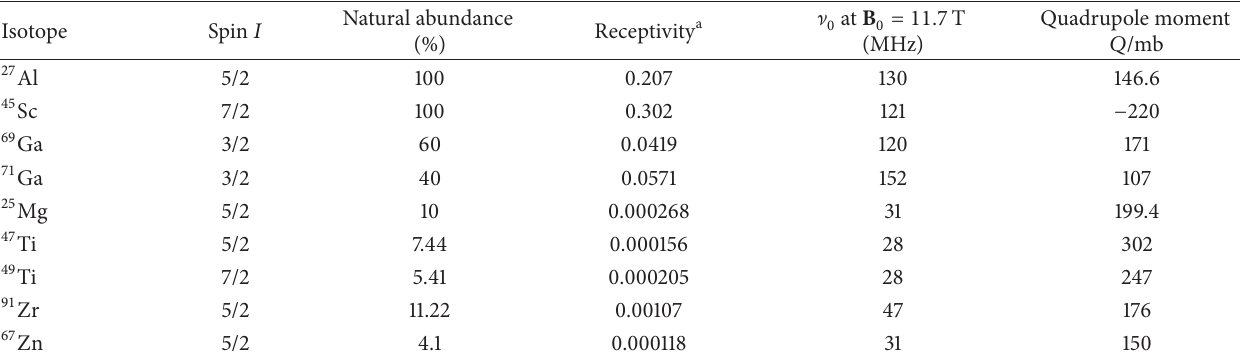
Table 1: Selected metal ions with different NMR properties b